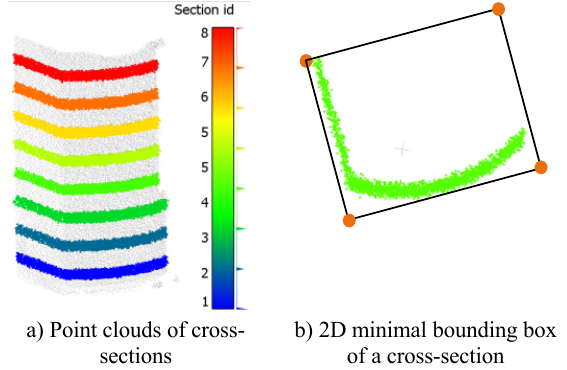
Figure 6 . Illustrate estimation of primary geometric dimensions